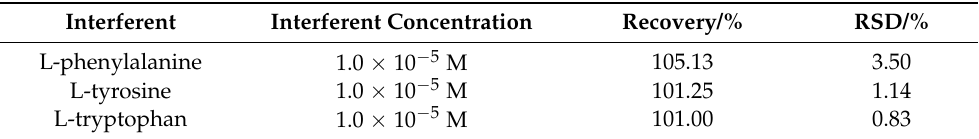
Table 6. Interference of chemically-related compounds on the detection of 10 − 6 M concentration